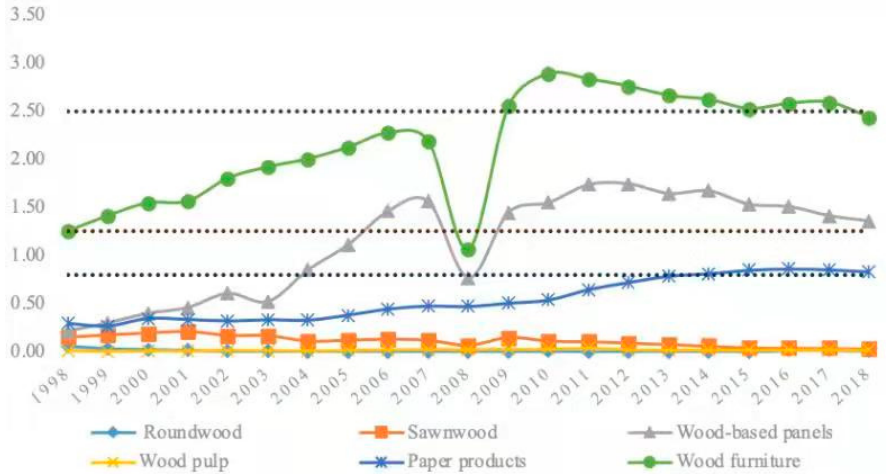
Figure 2. Changes in export competitiveness of wood forest products. Note: RCAij = (Xij/Xtj) ÷ (XiW/XtW); Xij indicates the exporting value of goods I from country j; Xtj indicates total exporting value of country j; XiW indicates the whole exporting value of goods I in the world; XtW indicates the total exporting value of the world. RCA > 2.5 means very strong competitiveness; 1.25 < RCA < 2.5 means strong competitiveness; 0.8 < RCA < 1.25 means moderate competitiveness; 0 < RCA < 0.8 means weak competitiveness (Balassa Bela, 1965). Source: calculated according to the data of the United Nations UNCOMTRADE database.